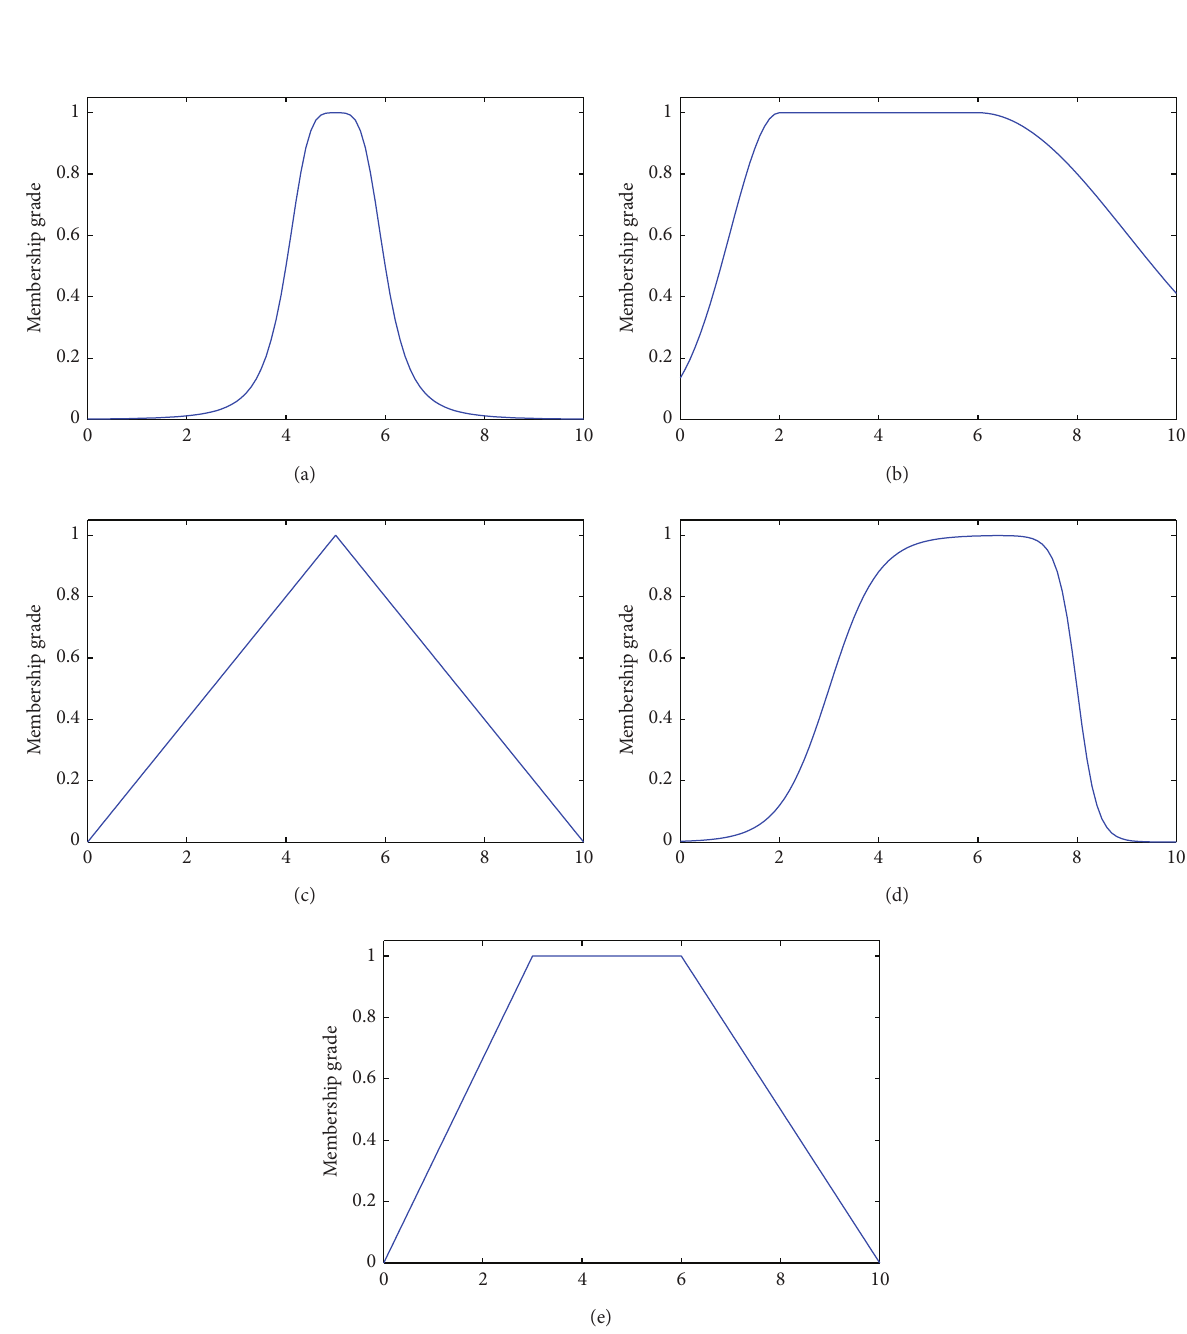
Figure 8: The type of MF: (a) Gaussian MF, (b) bell MF, (c) triangular MF, (d) sigmoidal MF, and (e) trapezoidal